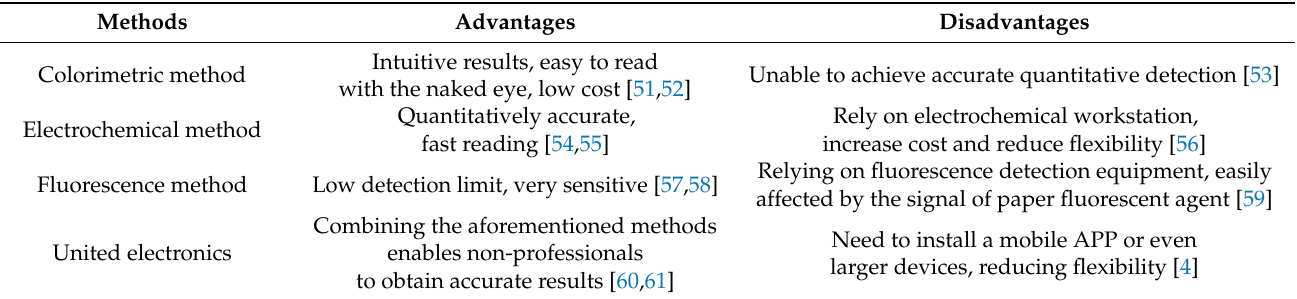
Table 3. Analysis Method of paper-based microfluidic chips.